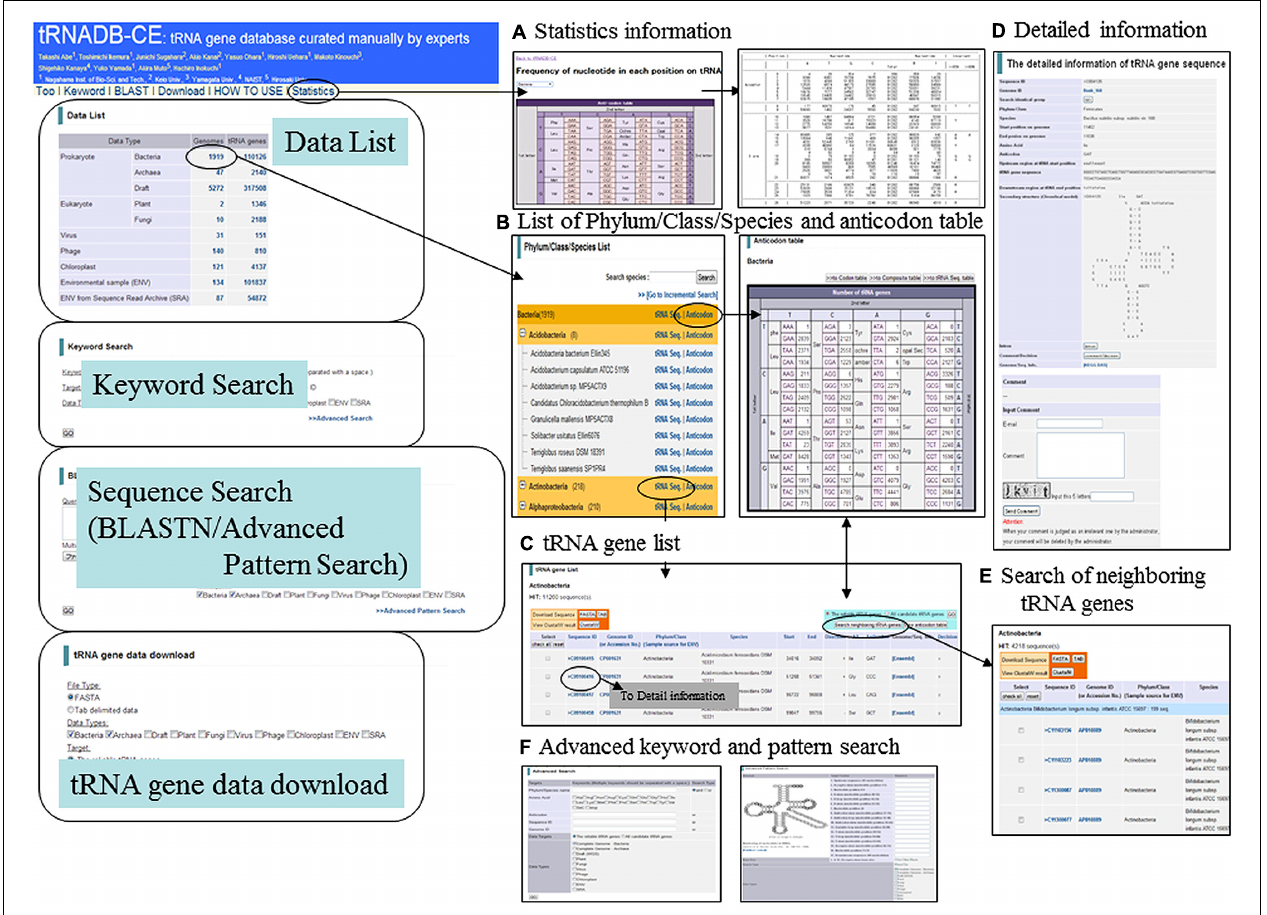
FIGURE 1 | Basic functions of tRNADB-CE. (A) Statistics information for frequency of nucleotide in each position on tRNA cloverleaf secondary structure, (B) List of Phylum/Class/Species and anticodon table, (C) tRNA gene list, (D) Detailed information, (E) Search of neighboring tRNA genes, and (F) Advanced keyword and pattern